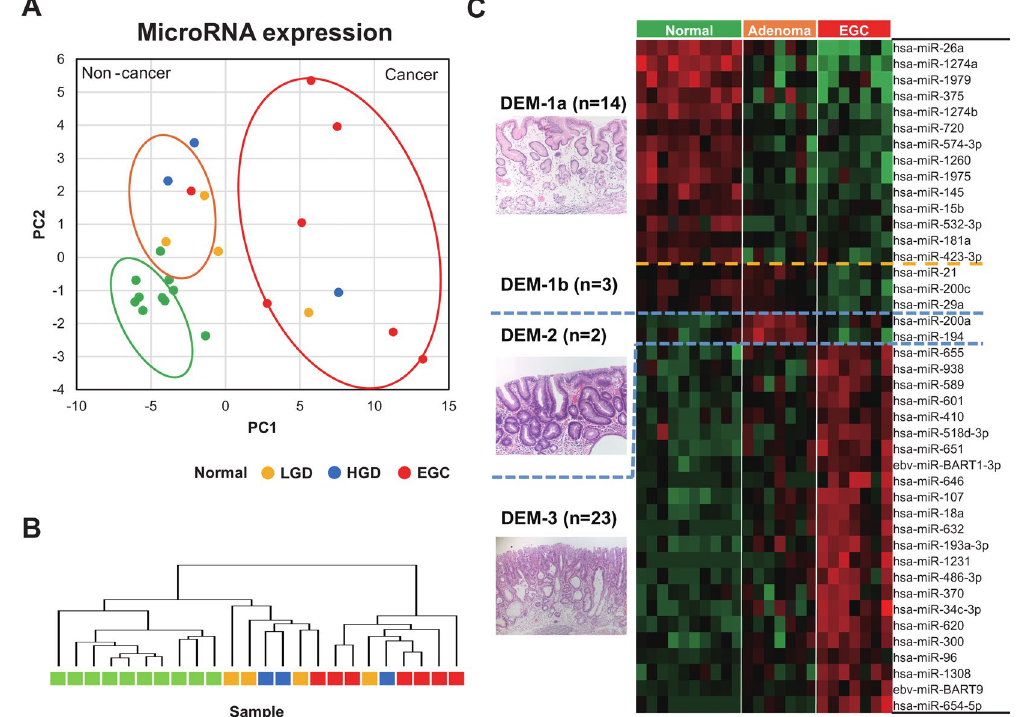
Figure 1. The expression profiles of miRNA for LGD, HGD, and EGC. ( A ) Principal component analysis of the whole set of miRNAs. ( B ) Results of un-supervised clustering analysis. ( C ) Differentially expressed miRNAs (DEM) among three groups. DEM-1 with highest expression levels in normal control mucosa, DEM-2 with highest miRNA expression levels in adenoma, and DEM-3 with upregulated miRNA in EGC with their representative histopathologic findings.